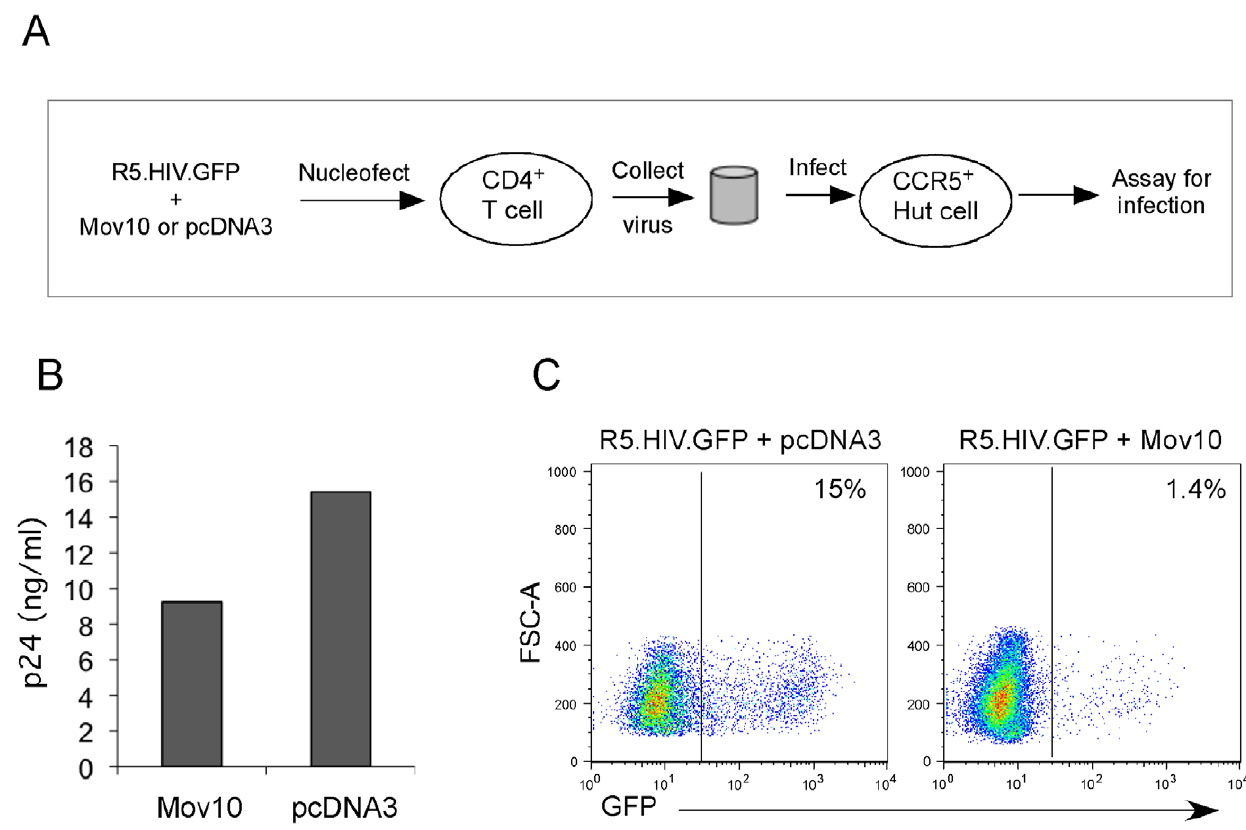
Figure 3. Mov10 impairs HIV-1 replication in primary CD4 + T cells. Supernatants of activated CD4 + cells that had been nucleofected with a replication competent, CCR5-tropic HIV-1 viral plasmid and either Mov10 or control (pcDNA3) plasmid ([ A ] schematic) were assayed for p24 production ( B ) and then standardized by p24 concentration and used to infect CCR5 + Hut cells. ( C ) Infection success was determined by flow cytometry analysis of GFP expression.